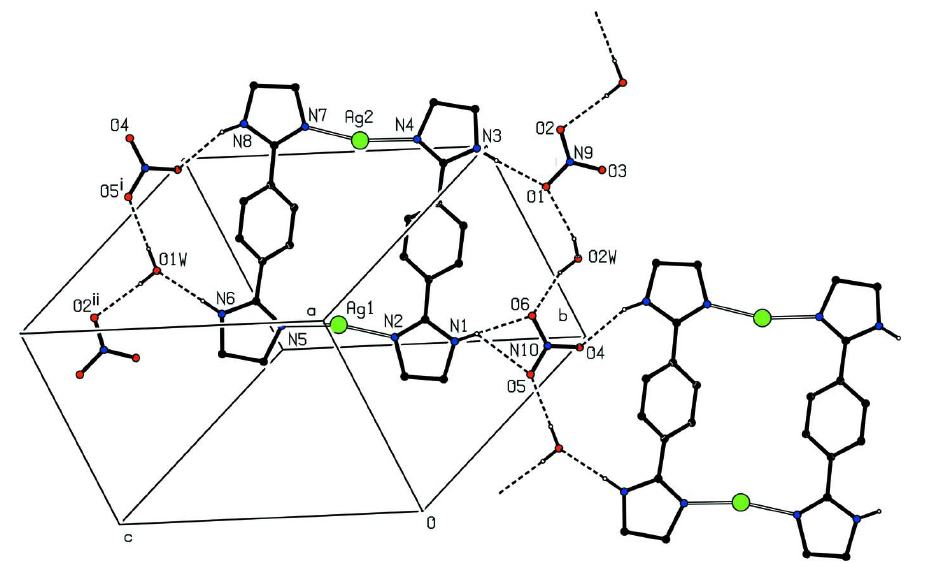
(bib) ](NO ) .2H O showing the hydrogen bond interactions as dashed lines. H atoms not 2 2 3 2 2